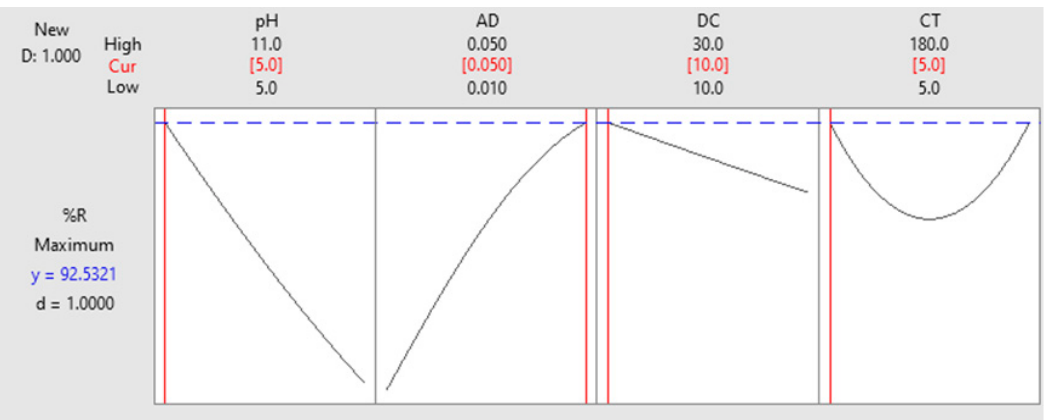
Figure 3. Optimization plot. A factorial combination of pH = 5.00 ± 0.20, AD = 0.050 g/50 mL, DC = 10 ppm and CT of 5 min. would achieve %R = 92.53%.